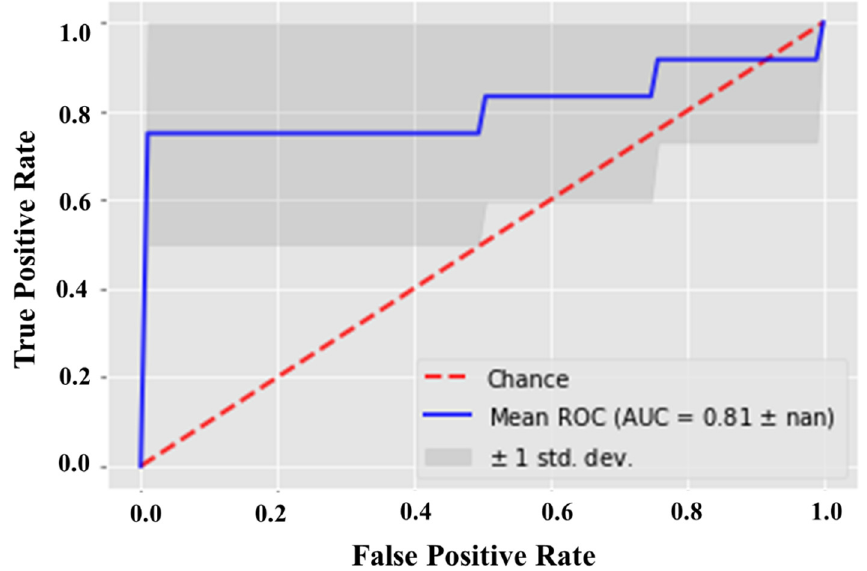
Figure 5. ROC curve validation by using 17 actives and 12,991 decoys, highlighting the efficiency of the modeled structure-based pharmacophore to reliably differentiate between true positives and false positives.